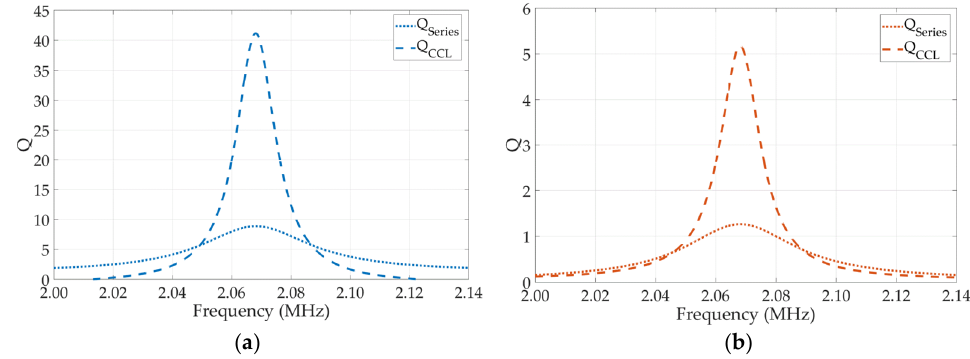
Figure 7. Comparison of Q factors between the series and CCL hybrid circuits when placed at ( a ) transmitter and ( b ) receiver sides. ( a ) transmitter and ( b ) receiver